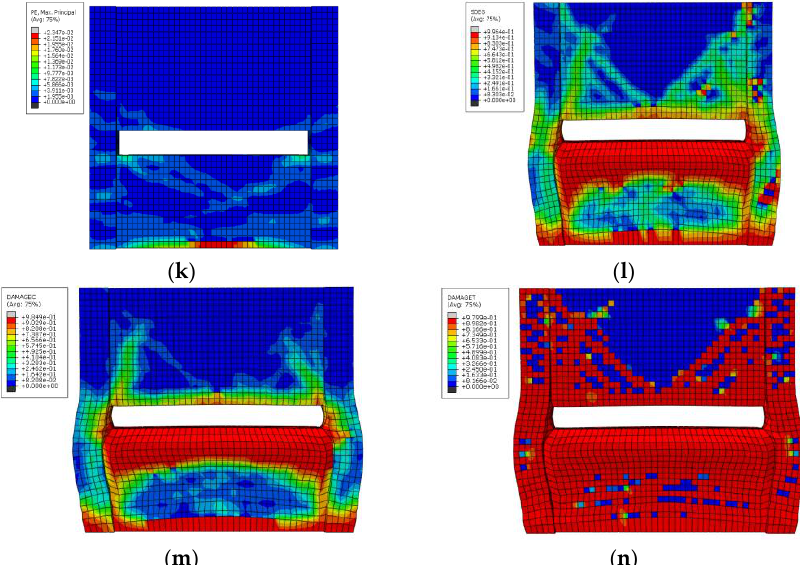
Figure 7. Failure process and failure form of GJ-2. ( a ) The first concrete plastic strain element at the left frame column foot; ( b ) crack development of left column foot; ( c ) the first concrete plastic strain element at the right frame column foot; ( d ) crack penetrated the wall and column; ( e ) the lower half of the wall begins to show oblique cracks; ( f ) yield of stressed bars of wall and columns; ( g ) devel- opment of the first right oblique crack of the lower half of the wall; ( h ) the first right oblique crack of the lower half of the wall penetrates; ( i ) development of the first left oblique crack of the lower half of the wall; ( j ) the first left oblique crack of the lower half of the wall penetrates; ( k ) development of the second right oblique crack of the lower half of the wall; ( l ) cloud chart of stiffness degradation of GJ-2; ( m ) cloud chart of compression failure of GJ-2; ( n ) cloud chart of tension failure of GJ-2.